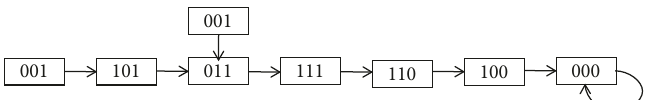
Figure 7: State diagram of NFSR with the feedback functions 𝑓 in Example 32.